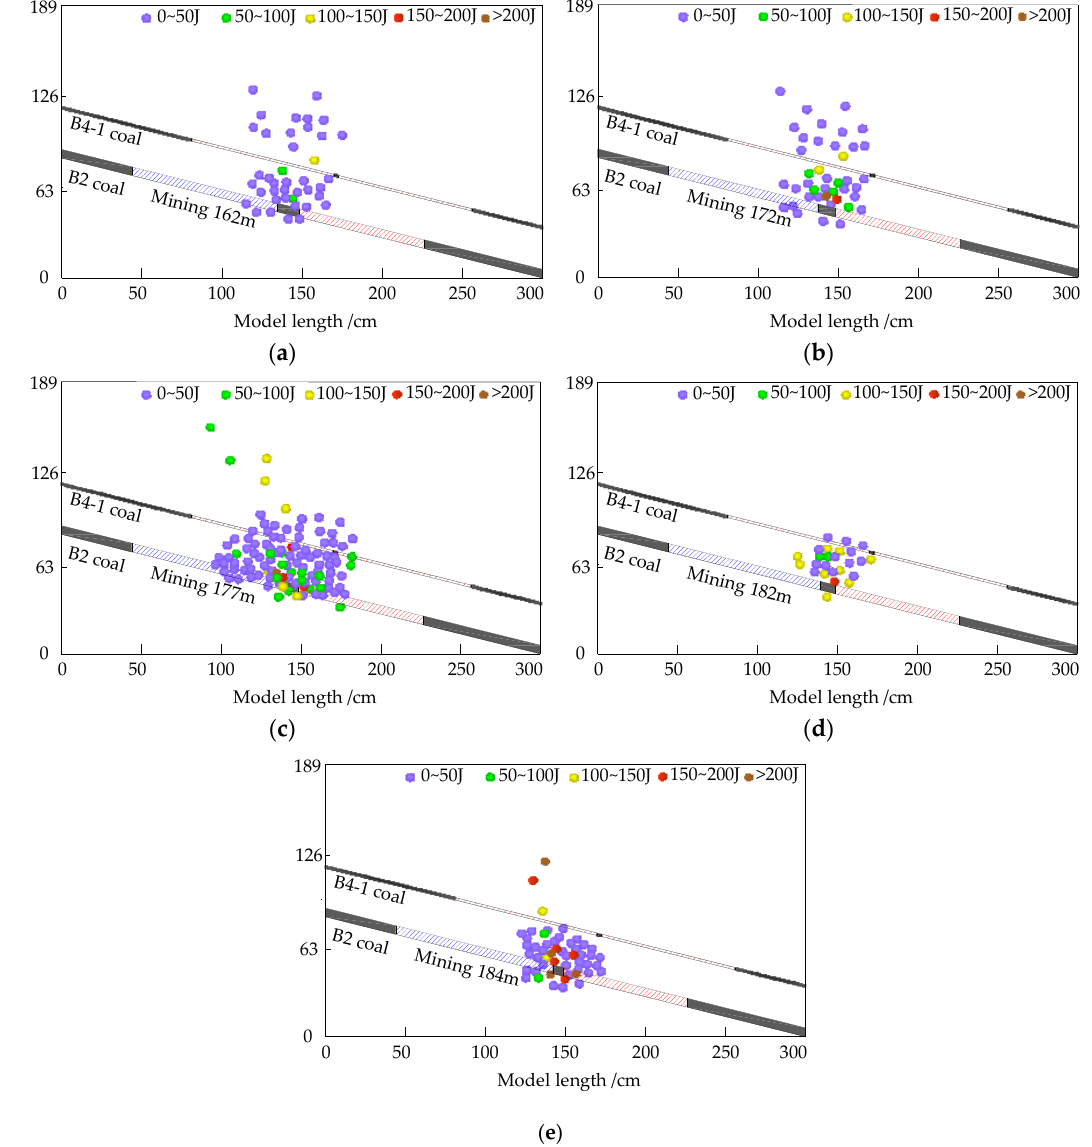
Figure 12. Location of MS events on working faces with different widths. ( a ) Mining 162 m; ( b ) mining 172 m; ( c ) mining 177 m; ( d ) mining 182 m; ( e ) mining 184 m.